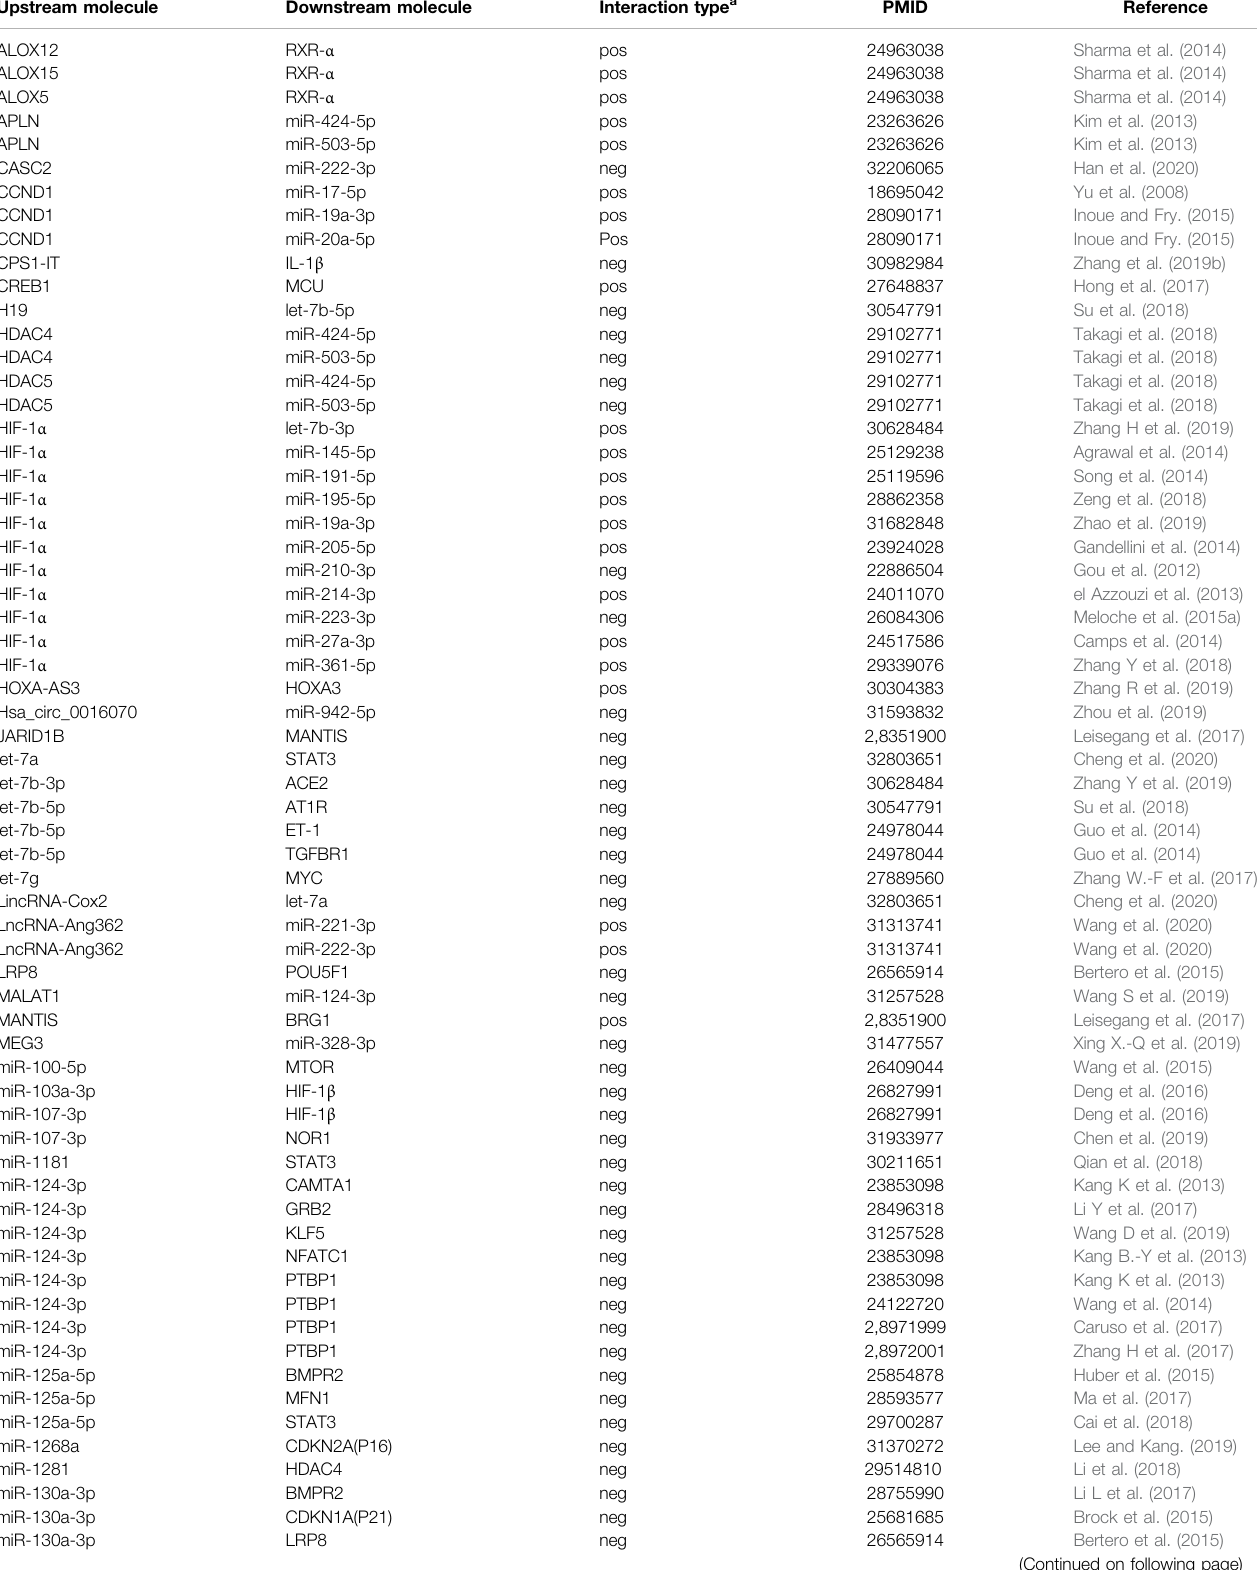
TABLE 2 | List of network interactions. Upstream